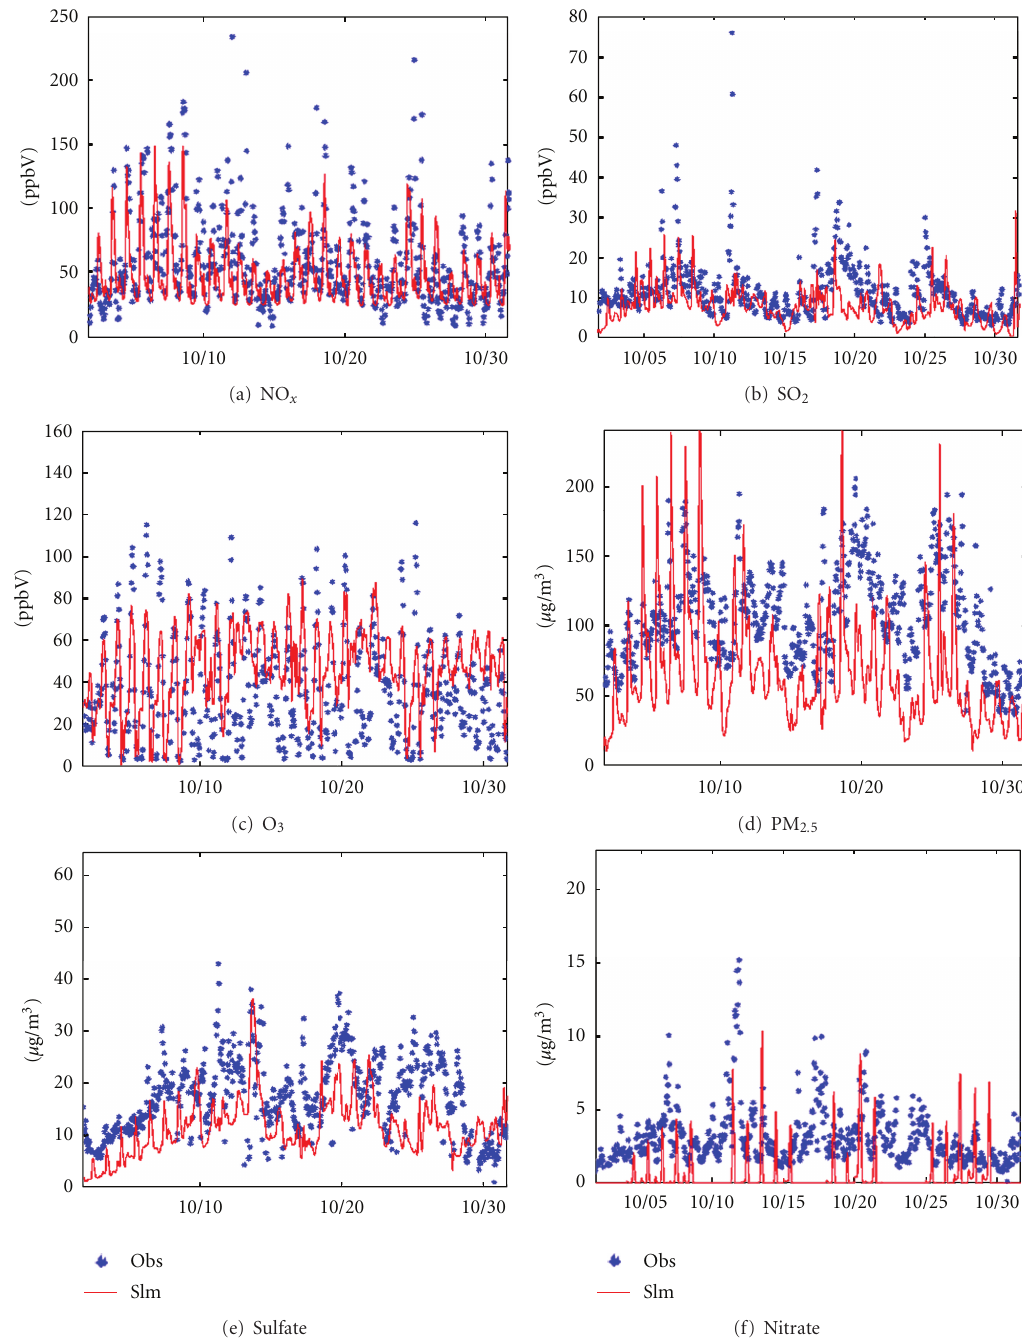
Figure 3: Comparison of modeled and observed (a) NO x , (b) SO 2 , (c) O 3 , (d) PM 2 . 5 , (e) aerosol sulfate, and (f) aerosol nitrate concentration at Yuen Long (YL) station in October